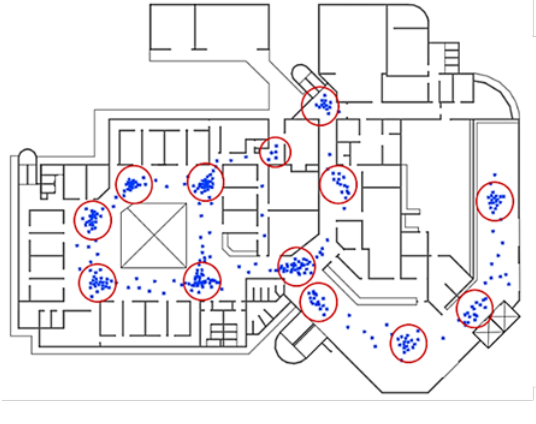
Furthermore, the VRE have registered a total of 574 pauses by the respondents, reg- istering a minimum of 35 pauses in task (3) and a maximum of 55 pauses in task (12). The respondents averaged 4.41 pauses per task in all the tasks given. Moreover, the VRE registered a total of 233 instances where the users used the pop-up orientation map option, averaging a 1.79 map call up per task across all tasks. The minimum no. of map requests per task was registered in task (4), and the maximum was registered in task (13). See Table 2. The pauses can be mapped on the building layout and to investigate the patterns of the pauses; Figure 10 illustrates the location of the pauses mapped on the building layout as well as highlights areas where the subjects made more pauses than others.